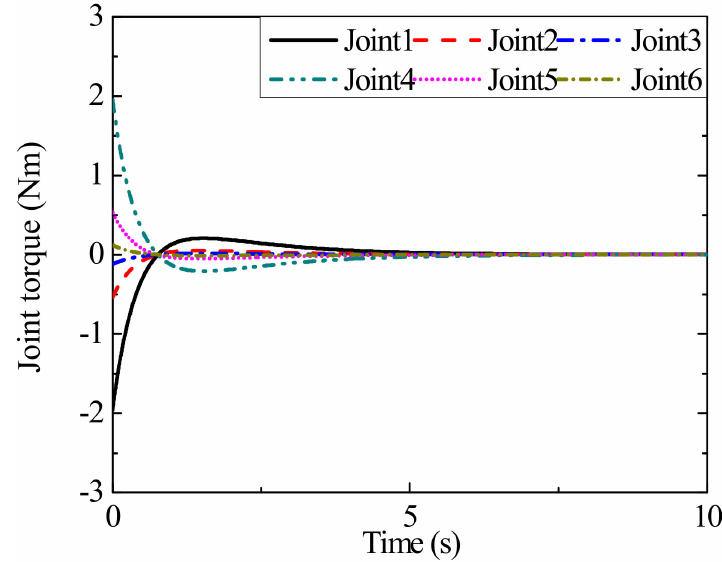
Figure 17. Control inputs in the trajectory tracking